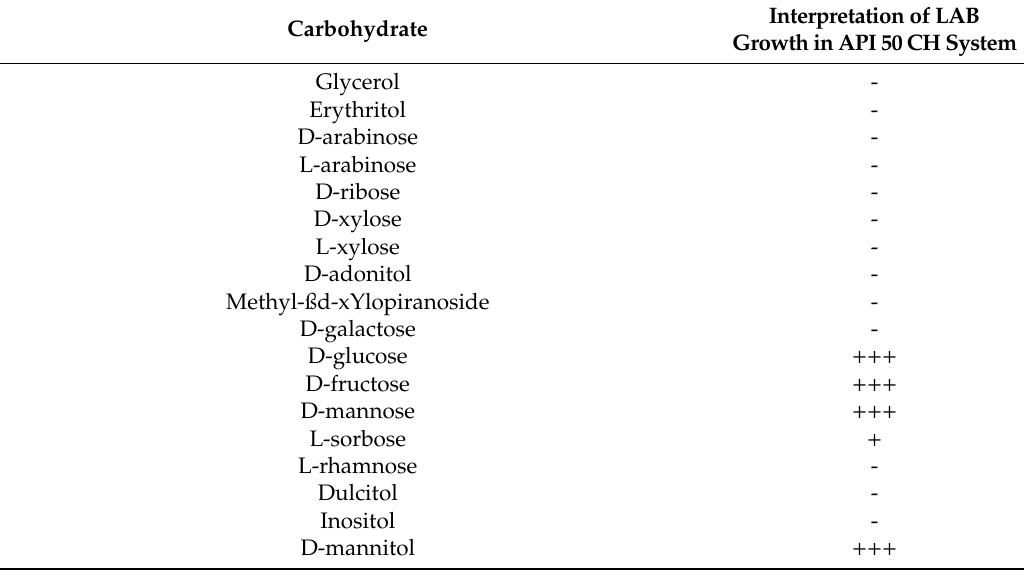
Table 1. Lactobacillus uvarum LUHS245 carbohydrate metabolism, gas production, and tolerance to temperature and low pH